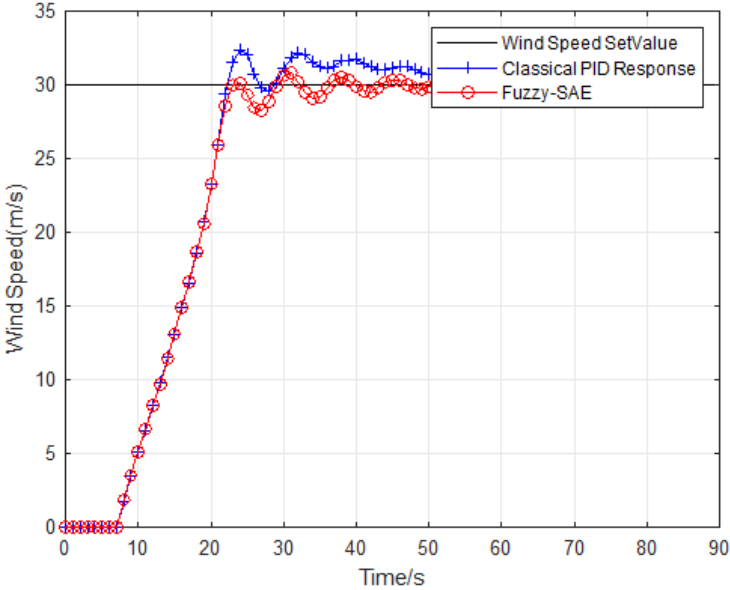
Figure 9. Curve of the classic PID algorithm and the fuzzy ‐ SAE algorithm based on measured data.